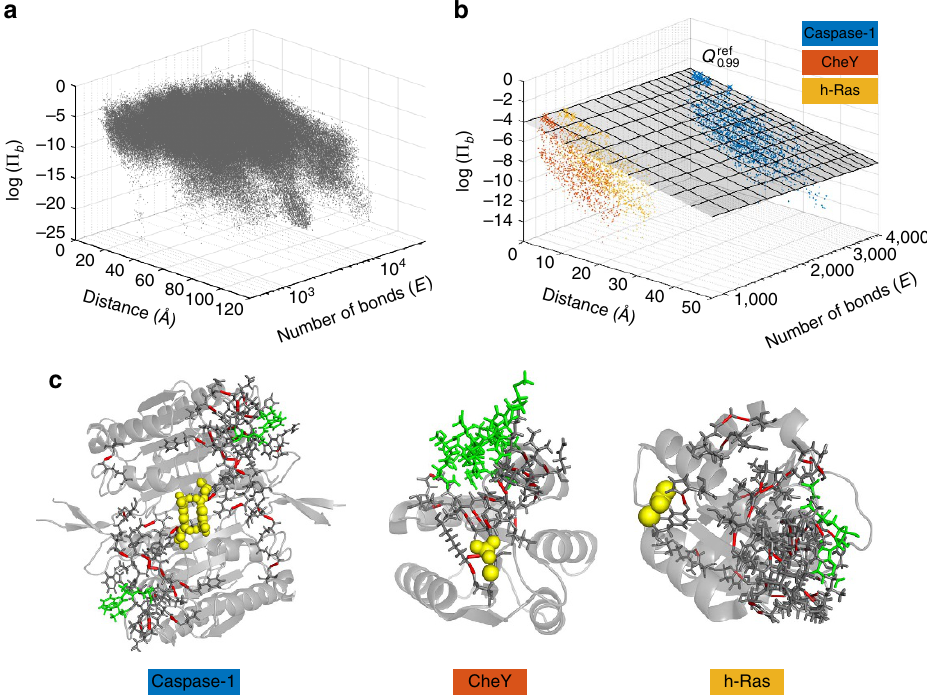
Figure 6 | Calibration of absolute propensities against the SCOP reference set. ( a ) The logarithm of the bond propensity log( P b ) of all 465,409 weak bonds in the reference set (100 proteins from the SCOP database) plotted against d , the distance from their corresponding active site, and E , where E is the number of weak bonds in the corresponding protein. ( b ) The log propensities log( P b ) for caspase-1 (blue), CheY (orange) and h-Ras (yellow) are plotted together with the plane defining the 99th quantile fit obtained by solving the optimization equation (15) against the SCOP set of bonds shown in a . For each of the three proteins, there are bonds lying above the 99th quantile plane. ( c ) The bonds above the plane in b have p ref corresponding protein structures (active-site ligand in green, allosteric ligand as yellow spheres). The bonds thus identified play key allosteric roles, in agreement with the ‘intrinsic’ results in previous